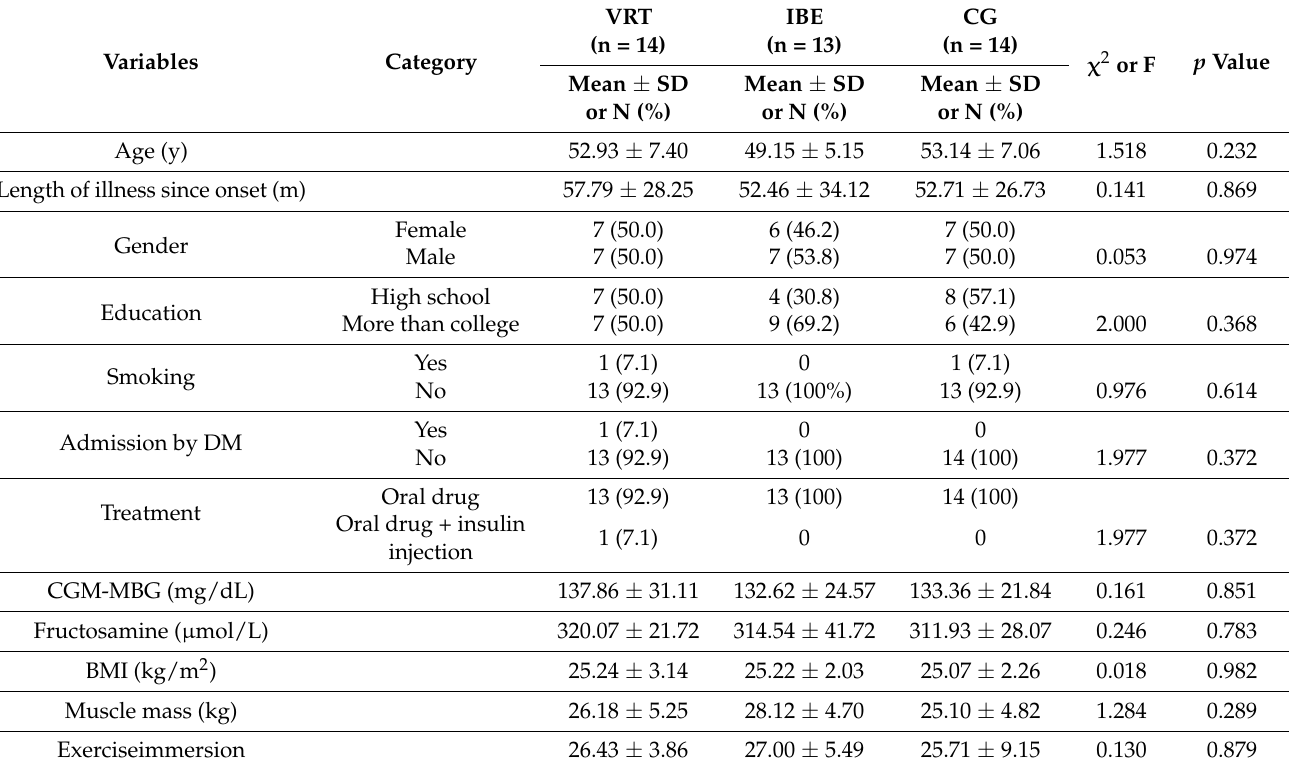
Table 1. Homogeneity test for general characteristics and dependent variables between the groups (N =